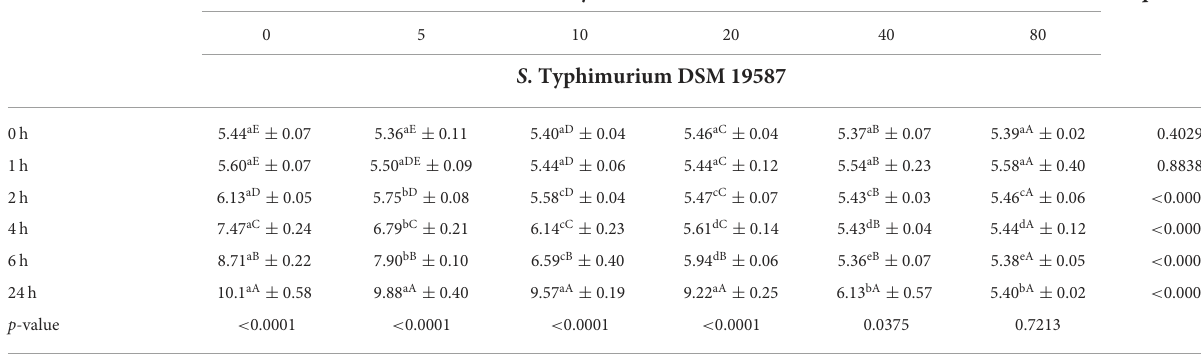
TABLE 1 Bacterial counts (mean ± SD) of S . Typhimurium DSM 19587 in log 10 CFU/mL in CAMHB 1 adjusted to a pH value of 6.0 exposed to different sodium butyrate concentrations at different incubation times, showing influence of concentration and incubation time ( n = 3). Incubation time